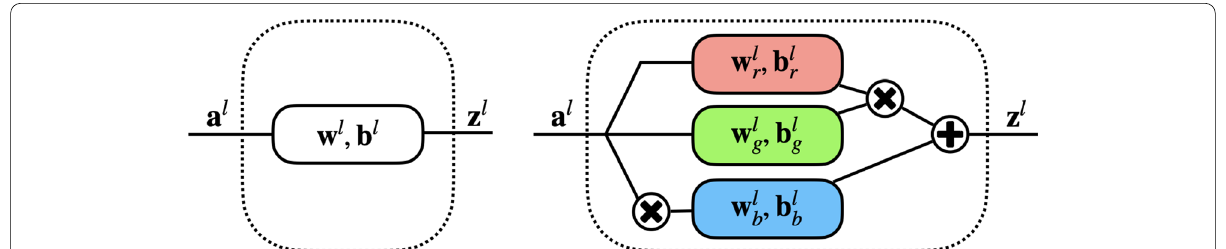
Fig. 3 Illustration of the affine layer of conventioinal (left) and quadratic (right) neurons respectively